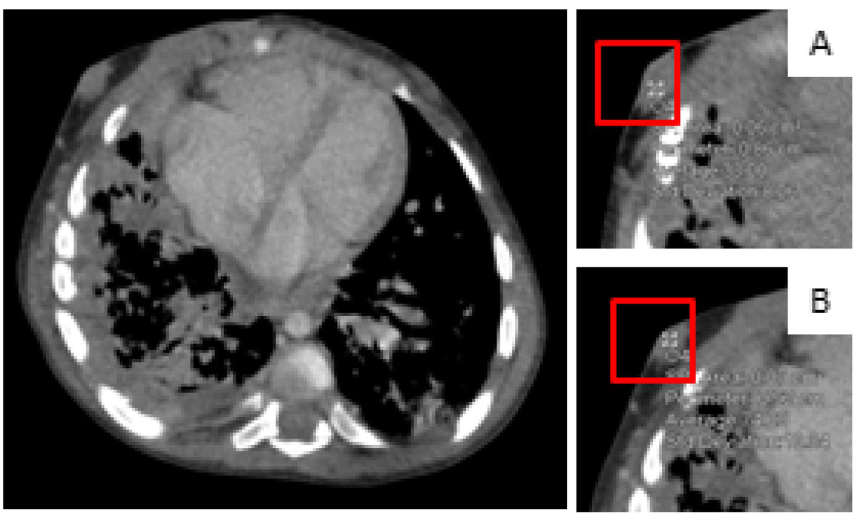
Fig. 2 Subcutaneous nodular lesion. A Mediastinal window without contrast injection showing a dense subcutaneous nodule of the anterior chest wall. B Enhancement of the subcutaneous nodule after contrast